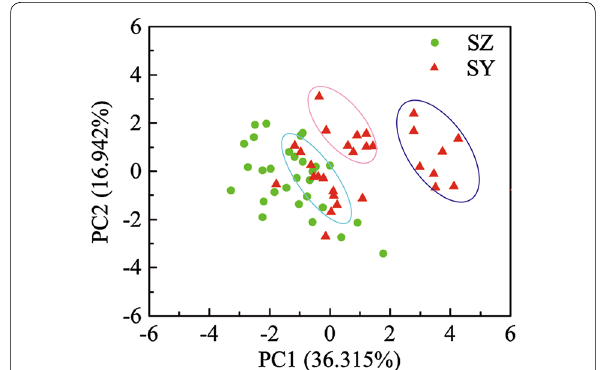
Fig. 6 PCA plot based on the physio-chemical variables in SZ and SY. The purple ellipse is mainly for July to October data, the pink ellipse is mainly for November to February data, and the blue ellipse is mainly for March to June data